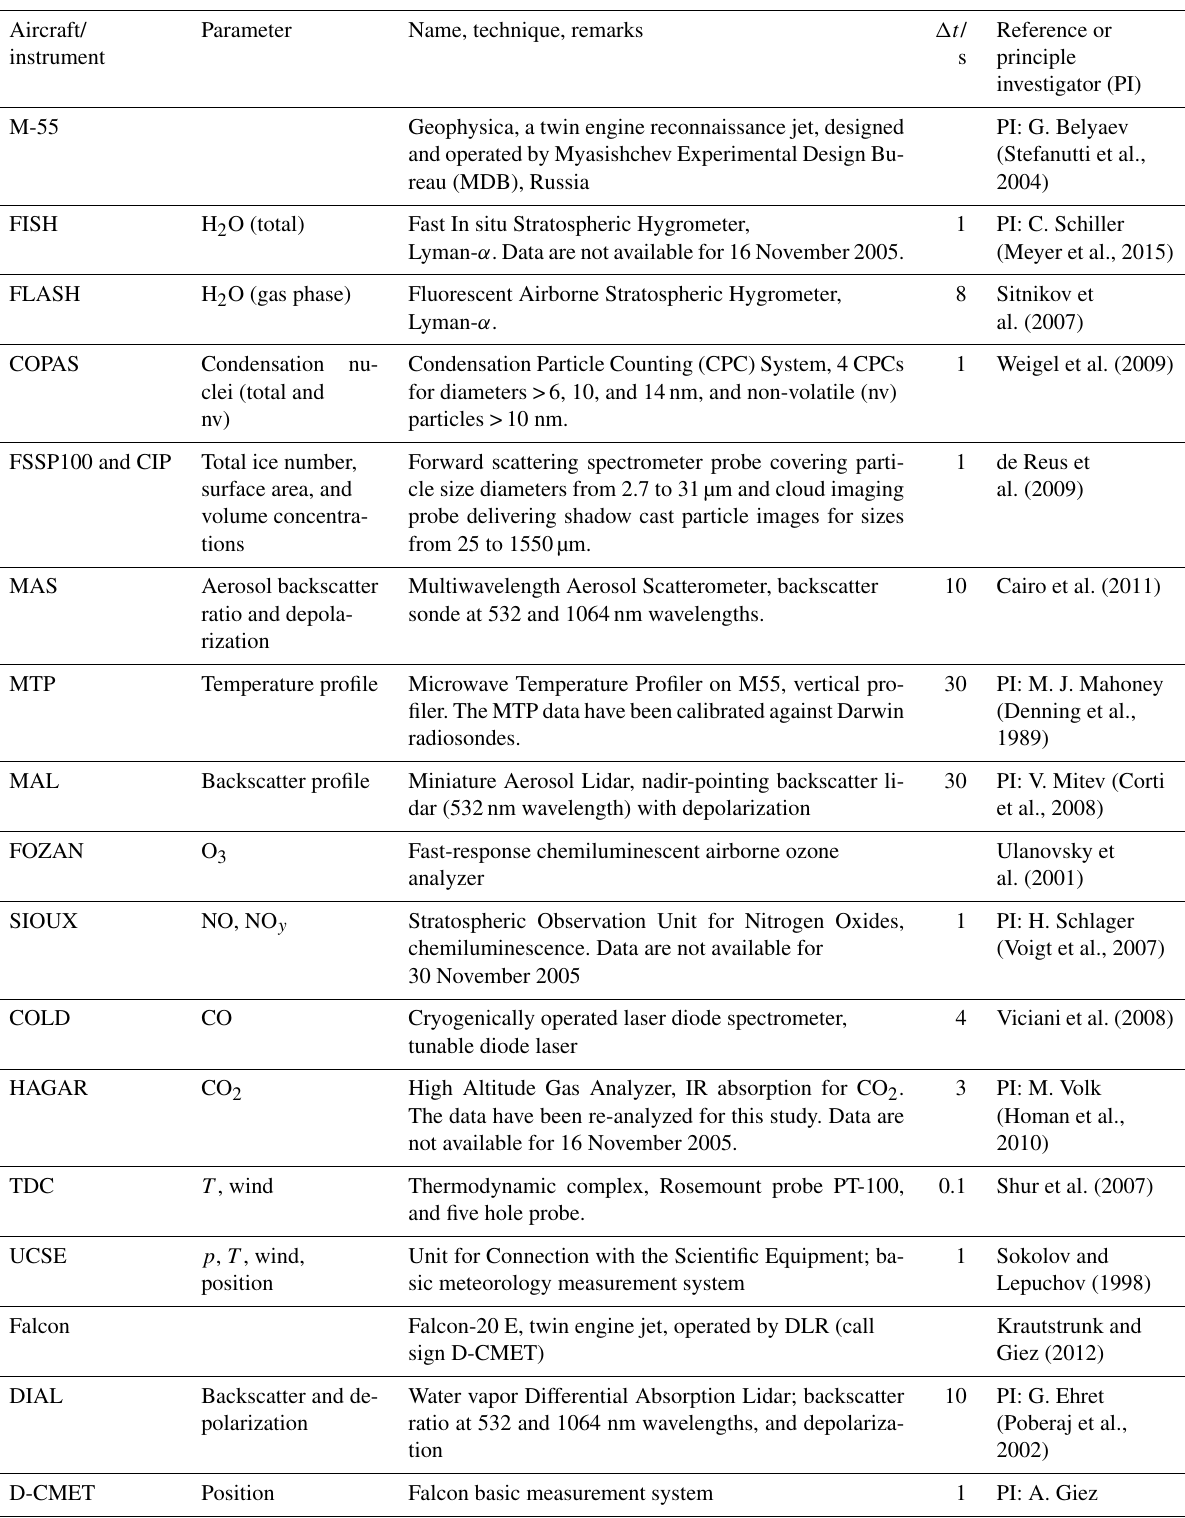
Table 1. Instruments (with time resolution (cid:49)t ) providing data for this study.